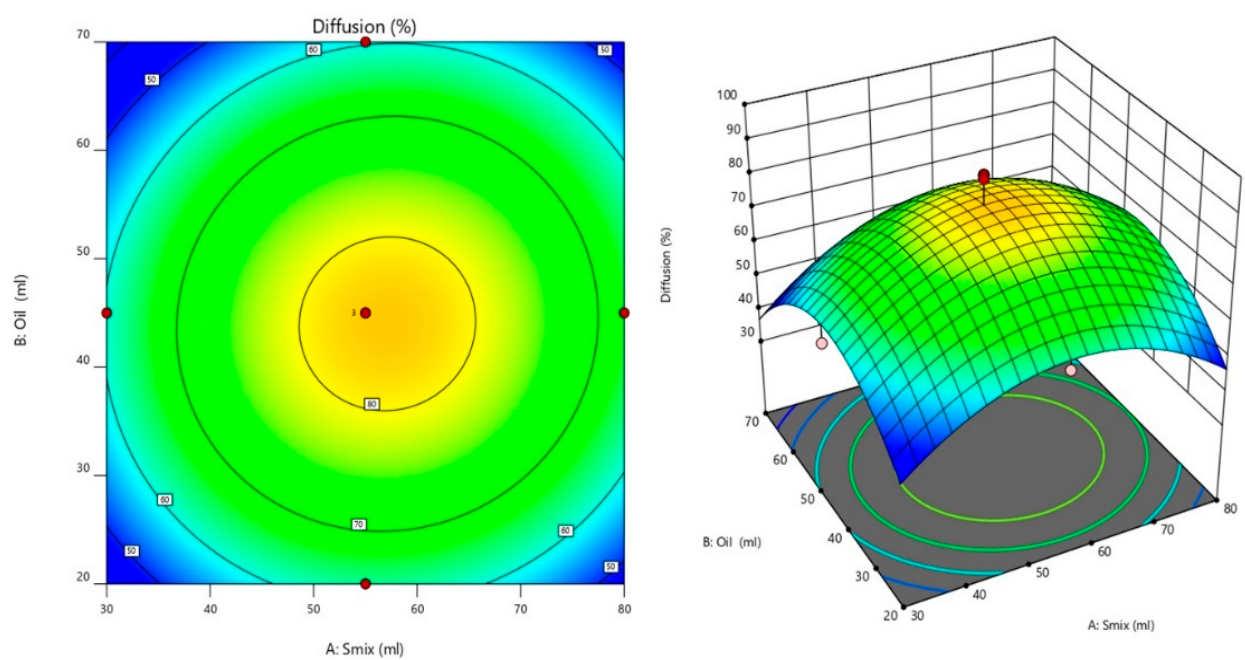
Figure 6. Perturbation plot and response surface plot for the effect of factors on diffusion. Table 4. Criteria for numerical optimization.